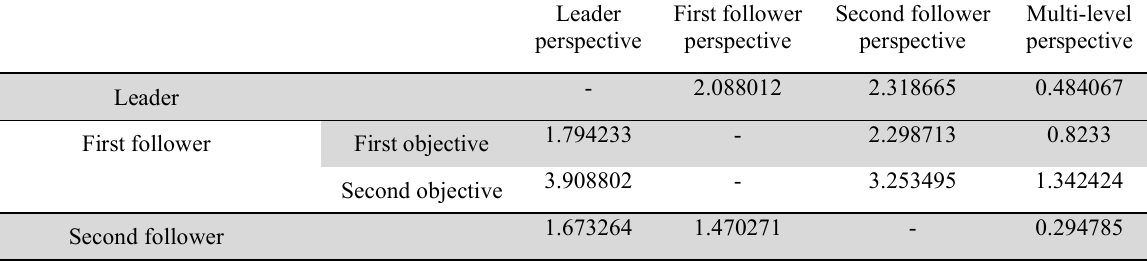
Leader perspective